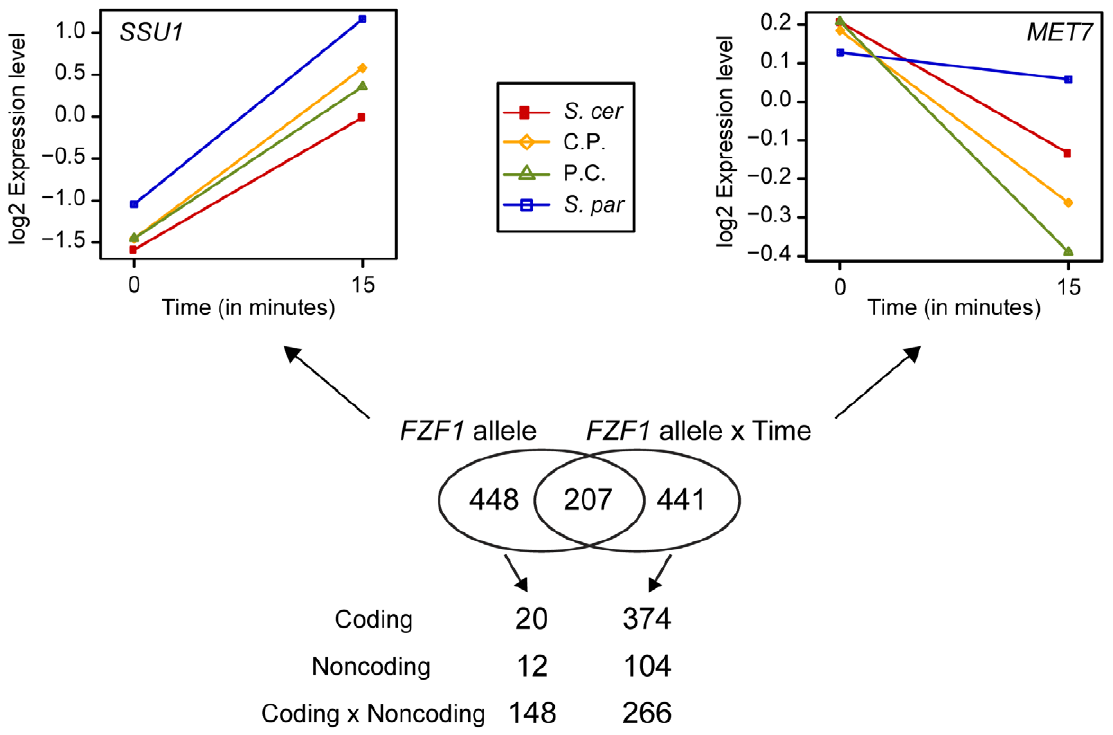
Figure 6. Changes in gene expression caused by FZF1 divergence. A Venn diagram of the number of genes with expression differences that depended on the FZF1 allele or an interaction between the FZF1 allele and time. An example of a gene with expression differences due to the FZF1 allele alone ( SSU1 ) or an interaction between the FZF1 allele and time ( MET7 ) are shown above the Venn diagram: S. cerevisiae ( S. cer , red), S. paradoxus ( S. par , blue), S. cerevisiae 5 9 noncoding with S. paradoxus coding (C.P., gold), S. paradoxus 5 9 noncoding and S. cerevisiae coding (P.C., green). The number of genes with expression differences that can be attributed to the coding region, upstream noncoding region or an interaction between the two regions is shown below the Venn